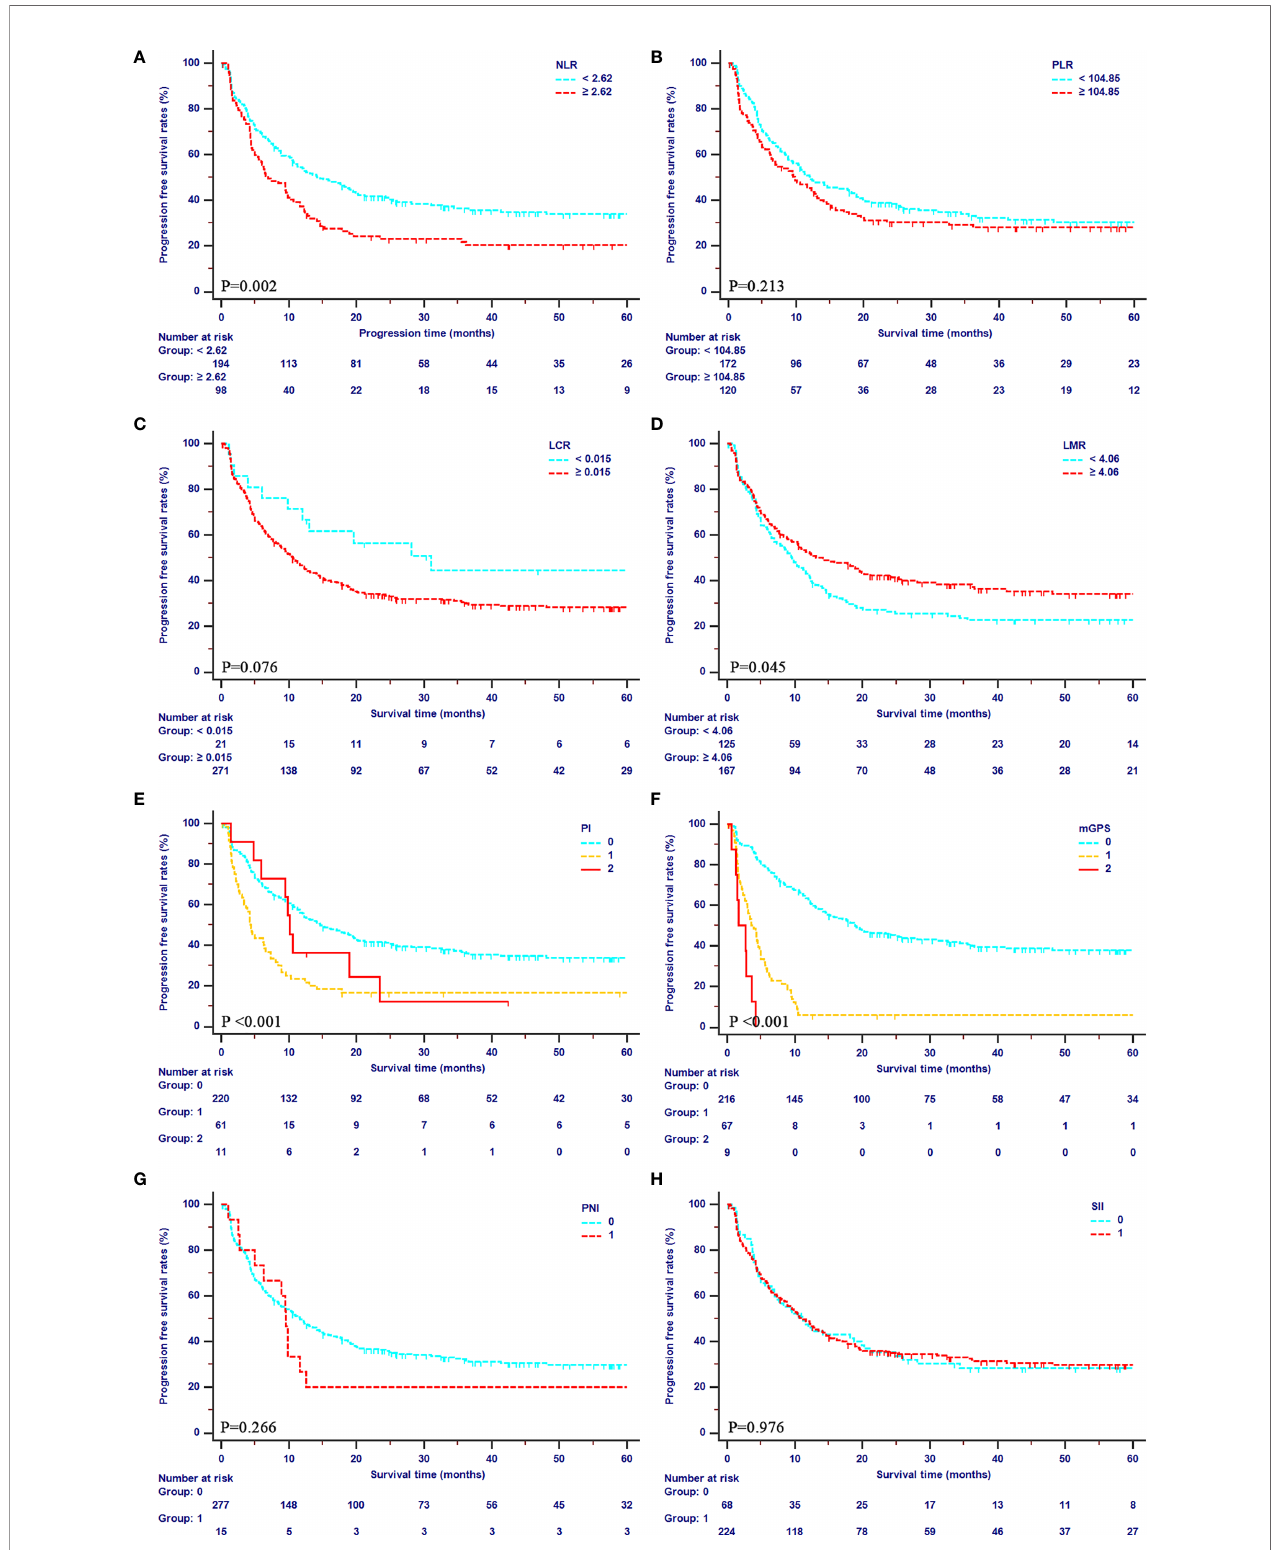
FIGURE 3 | Kaplan-Meier curves for PFS in patients with iCCA in the SYSUCC cohort strati fi ed by the in fl ammation-based score systems. (A) , NLR; (B) , PLR; (C) , LCR; (D) , LMR; (E) , PI; (F) , mGPS; (G) , PNI; (H) ,